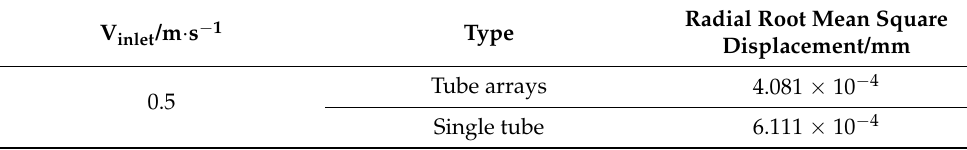
Figure 8. C3 vibration response. Table 3. Radial root mean square displacement of the C3 vibration